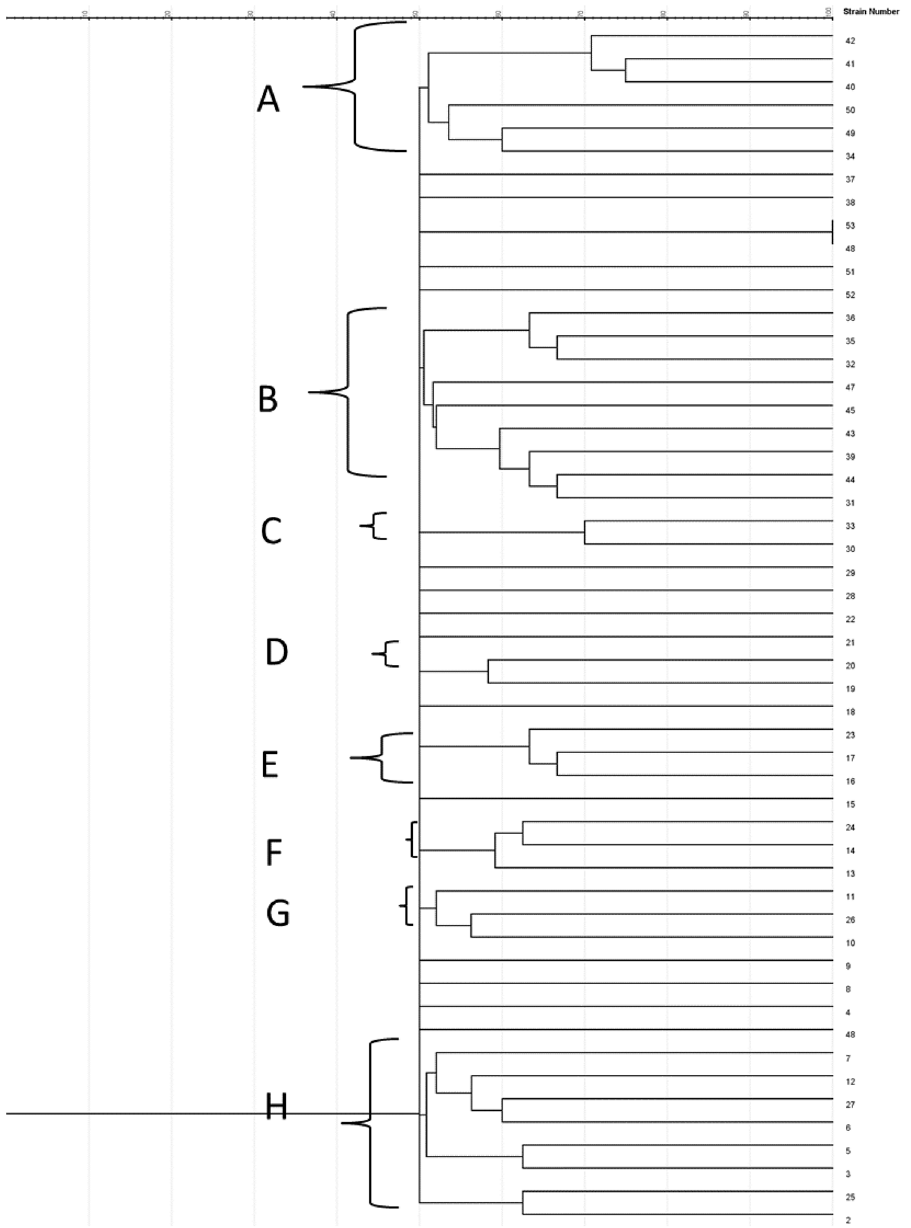
Figure 6. Dendrogram of ERIC PCR analysis for A. baumanni from environmental